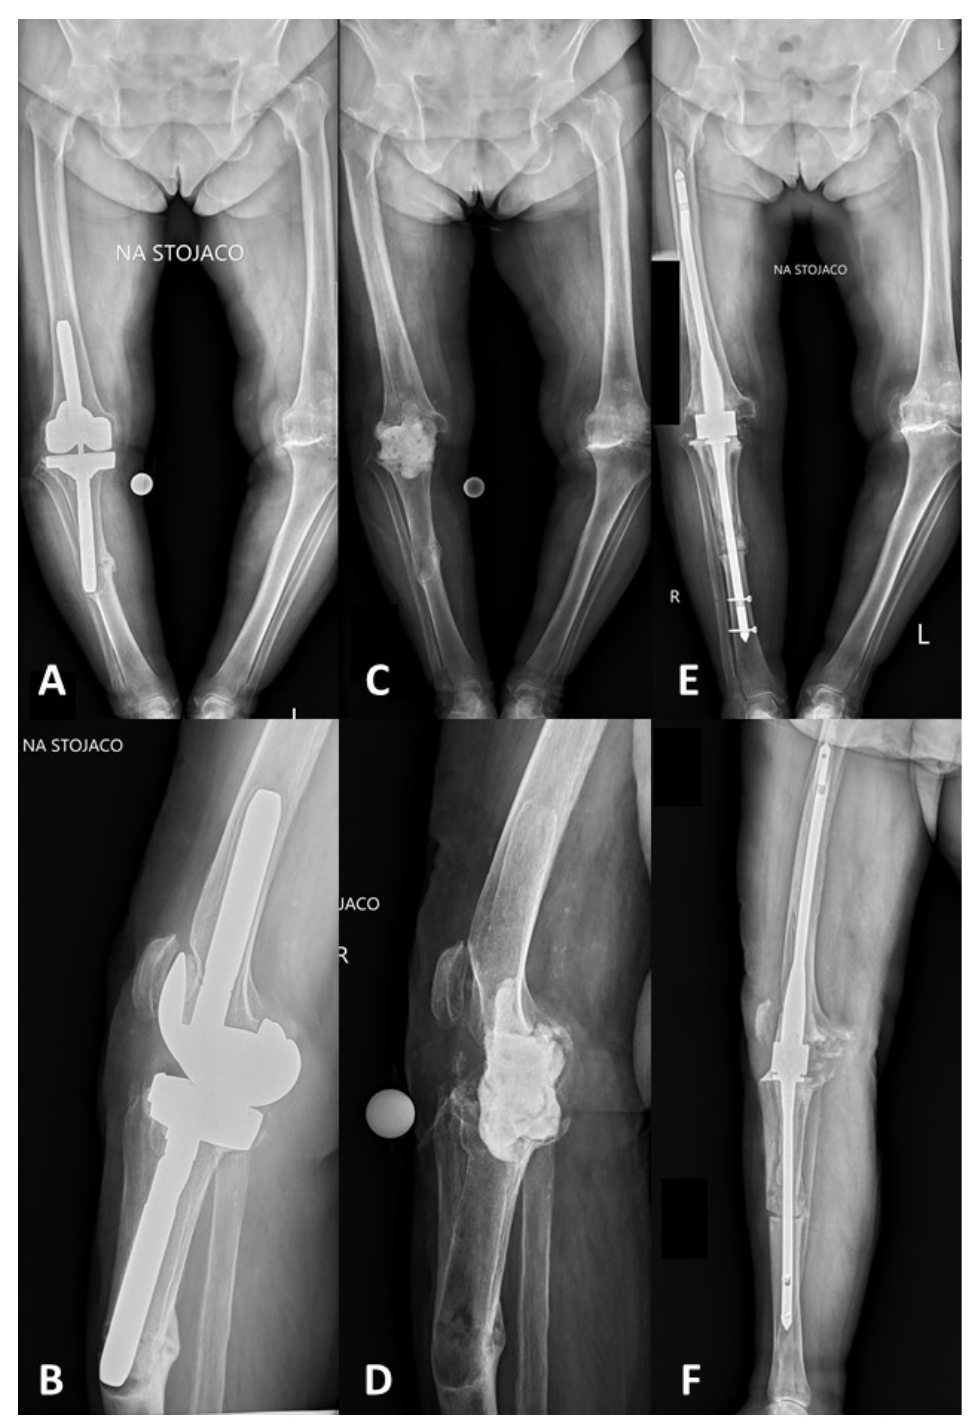
Figure 2. Radiographs of the patient (patient no. 1 in Table 1) with confirmed fungal PJI caused by Candida parapsilosis . ( A ) Preoperative AP long-standing radiograph and ( B ) lateral knee radiograph. ( C ) Long-standing AP and ( D ) lateral radiographs after revision surgery and static spacer implantation contained antibiotics. ( E ) Long-standing AP and ( F ) lateral radiographs after knee arthrodesis using a dedicated Charfix2 FN intramedullary nail (ChM, Lewickie, Poland).